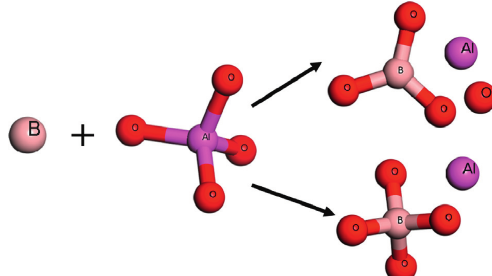
Figure 9: Schematic of the generation of the B-O three-coordination structure and B-O four-coordination